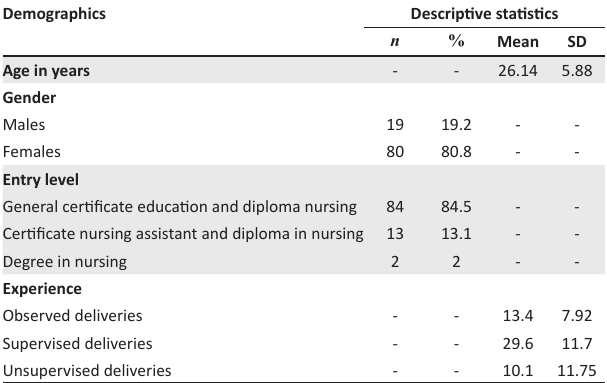
TABLE 2: Characteristics of respondents ( n =